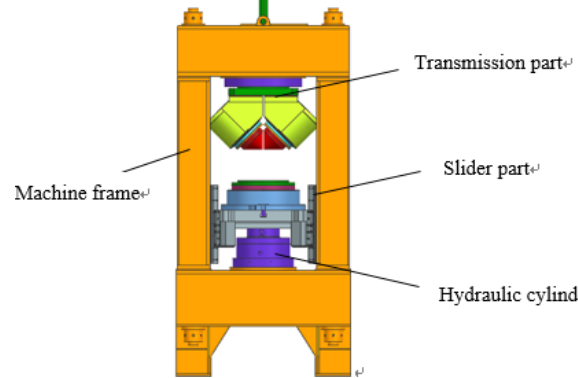
Figure 2. Diagram of double roll rotary forging